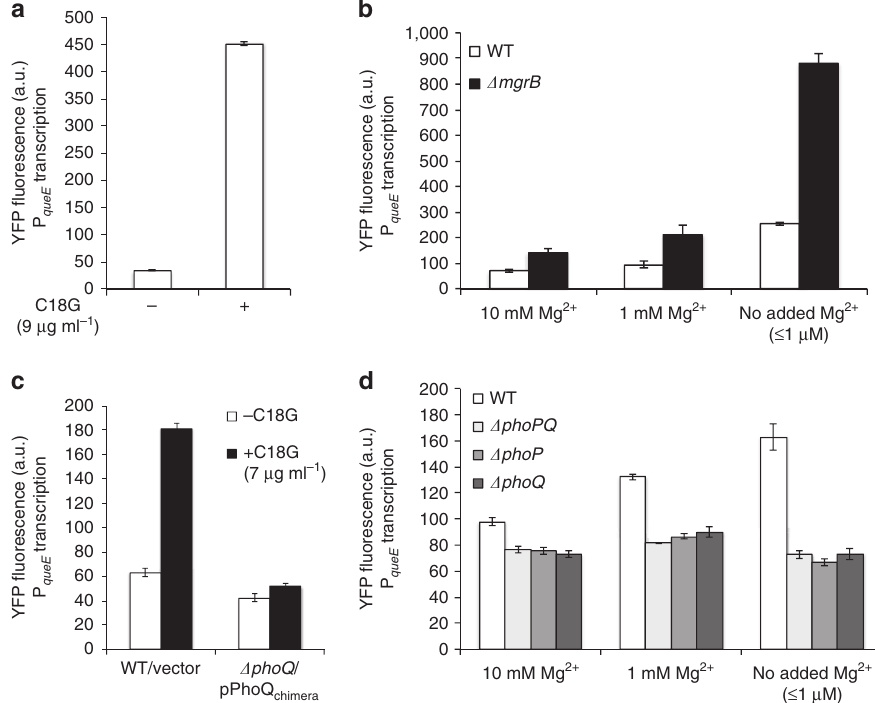
Figure 4 | The PhoQ/PhoP system regulates queE transcription. ( a ) YFP fluorescence of a queE-yfp operon fusion measured in wild-type cells (SAM54) growing in the presence ( þ ) or absence ( (cid:2) ) of C18G (9 m gml (cid:2) 1 ) in minimal medium containing 0.1mM Mg 2 þ . Data represent the means and ranges of two independent cultures. ( b ) YFP fluorescence measured from a queE-yfp operon fusion in wild-type (SAM54) and D mgrB (SAM55) strains in minimal medium at the indicated Mg 2 þ concentrations. Data represent means and s.d.’s from at least three independent experiments. ( c ) YFP fluorescence of a queE-yfp operon fusion measured in wild-type cells containing a control plasmid (SAM54/pGB2) and D phoQ cells containing a plasmid encoding PhoQ chimera (SAM60/pLPQ*2) grown in the presence ( þ ) or absence ( (cid:2) ) of C18G (7 m gml (cid:2) 1 ) in minimal medium containing 0.1mM Mg 2 þ . Data represent the means and s.d.’s from at least three independent experiments. The PhoQ chimera protein, which is not stimulated by C18G but has a basal level of PhoQ activity, was used to avoid problems due to the high toxicity of C18G in D phoQ strains. ( d ) YFP fluorescence measured from a queE-yfp operon fusion in wild-type (SAM54), D phoPQ (SAM141), D phoP (SAM142) and D phoQ (SAM60) strains in minimal medium at the indicated Mg 2 þ concentration. Data represent the means and ranges of two independent